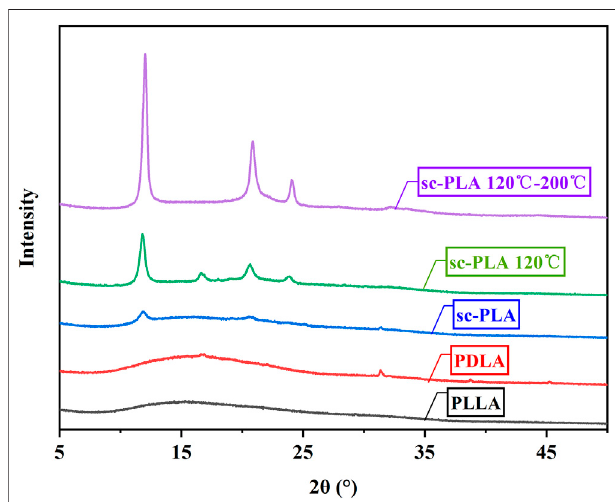
FIGURE 4 | XRD patterns of electrospun fi bers of PLLA, PDLA, sc-PLA, sc-PLA 120 ° C, and sc-PLA 120 – 200 °